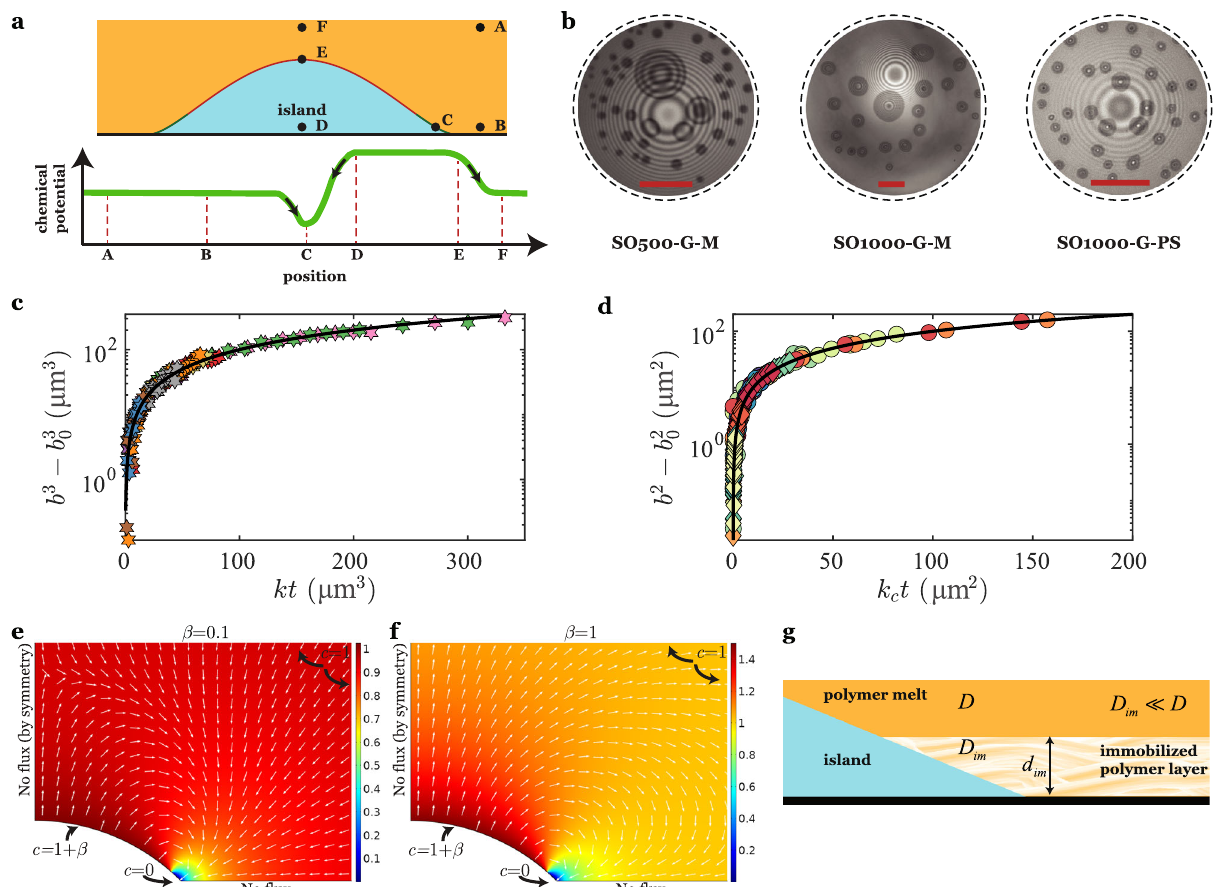
Fig. 4 Disjoining pressure-induced modi fi cation of solubility near the contact line drives the net growth of islands. a Schematic indicating key locations for the consideration of the chemical potential of dissolved glycerol (top), and a sketch of the variation of the chemical potential along the path A → B → C → D → E → F. b RICM images showing the growing glycerol islands underneath a large glycerol droplet (see Supplementary Movies 3 and 4 for time lapse videos) for different cases of substrate and drop-suspending phase combinations. Scale bar: 10 µ m (circular crop). c The growth of islands on the þ kt (mean k value of 40 µ m 3 h − 1 ). d The growth of islands on the mica surface follows the plasma-treated SU-8 surface follows the relationship, b 3 ¼ b 3 0 þ k µ m 2 h − 1 ). e , f The Laplace equation ∇ 2 c ¼ 0 was setup and solved in COMSOL, where c is the relationship, b 2 ¼ b 2 c t (mean k c value of 1.3 0 Þ on the island surface, concentration of the dissolved species in the suspending medium. The applied boundary conditions were: (I) c ¼ ð 1 þ β Þ H ð z (cid:3) z 0 where H is the Heaviside step function, (II) symmetry on the left edge, (III) no fl ux at the bottom surface owing to an impenetrable substrate, and (IV) c = 1 far away from the island. The parameters used in the simulation were: the contact angle, θ ¼ π = 4, island base radius, b = 1, and z 0 ¼ 0 : 2 tan ð θ = 2 Þ . The parameter β is the fractional increase in solubility owing to the curvature of the island. Simulations show net in fl ux into (Fig. 4e; β = 0.1) or out fl ux from (Fig. 4f; β = 1) the island for weak and strong augmentations, respectively, of the solubility by the curvature of the island. The white quiver plot indicates the direction of the mass fl ux vector for the dissolved drop fl uid. g An immobilized layer of silicone oil near the mica surfaces leads to a decrease in glycerol diffusivity. The rate-limiting step for mass transfer is diffusion across this immobilized